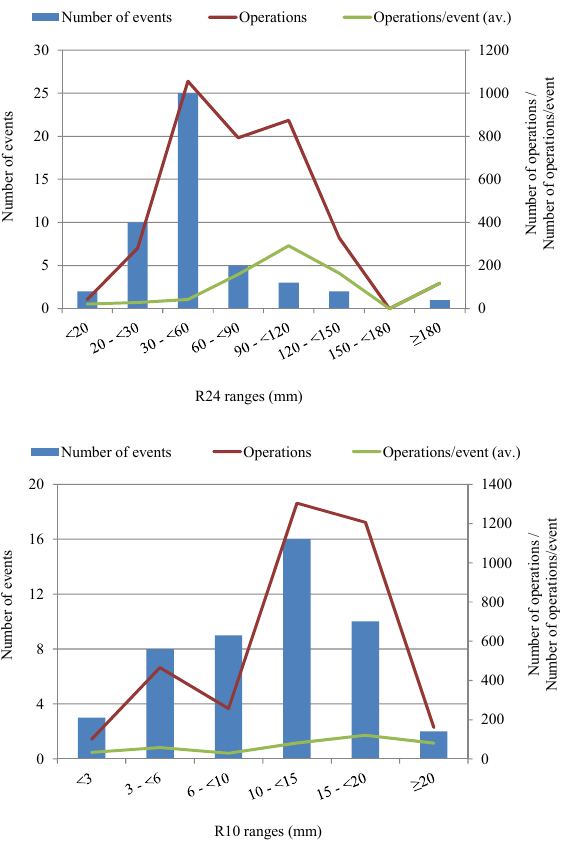
Figure 5. Number of events, fire service operations and average number of operations per event for various ranges of maximum (a) 24h (R24) and (b) 10min (R10) accumulated rain (in